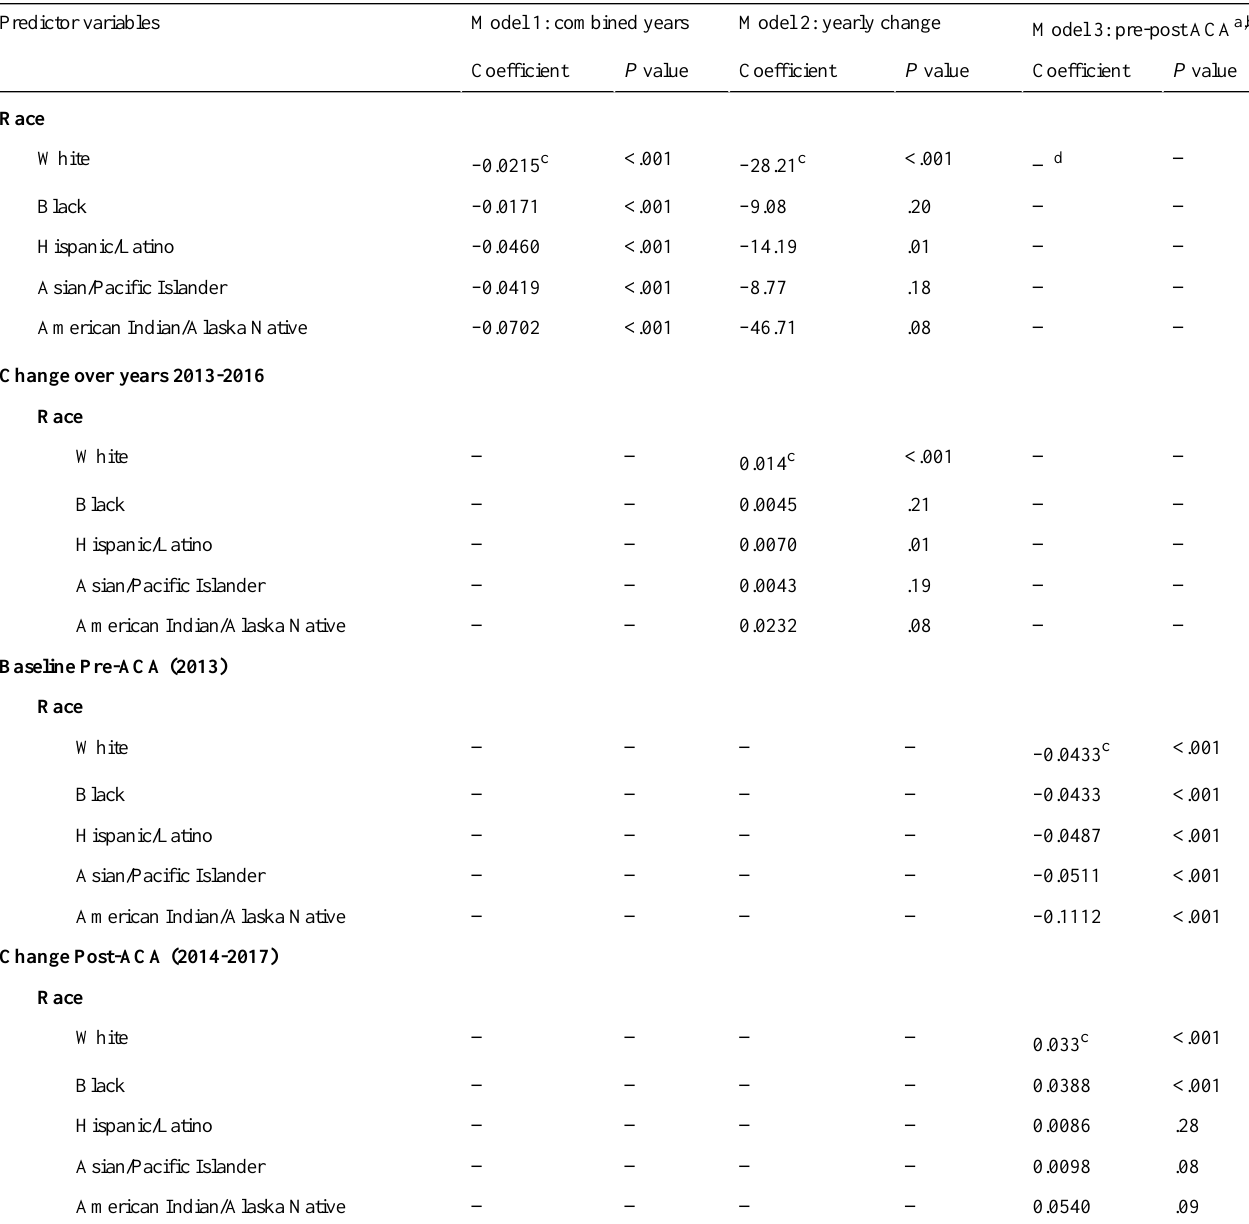
Table 2. Ordinary least squares modeling effects of year and racial and ethnic group on patient experience